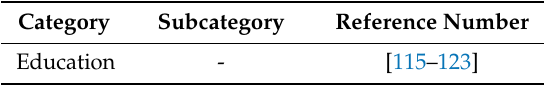
Table 4. Publications in the category of education.